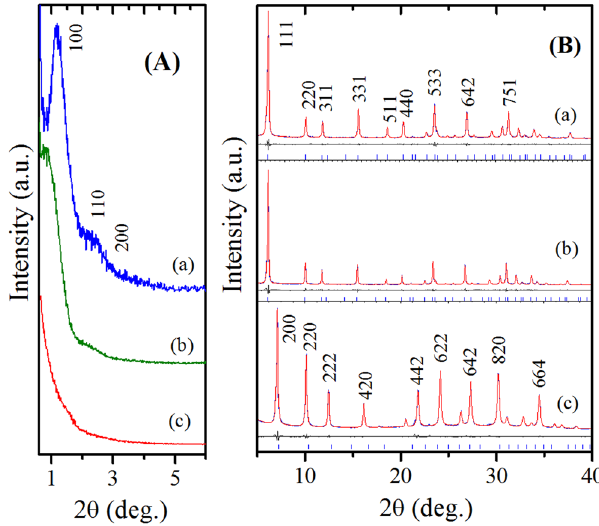
Figure 3. Low-angle ( A ) and high-angle (Rietveld-refined) XRD patterns ( B ) of: (a) ZH-Y; (b) ZH-X; (c) ZH-A.